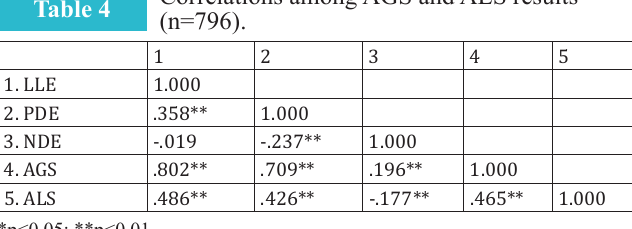
LLE: Limiting the Lives of the Elderly, PDE: Positive Discrimination toward the Elderly, NDE: Negative Discrimination toward the Elderly, AGS: Ageism Scale, ALS: Altruism Scale Correlations among AGS and ALS results (n=796).